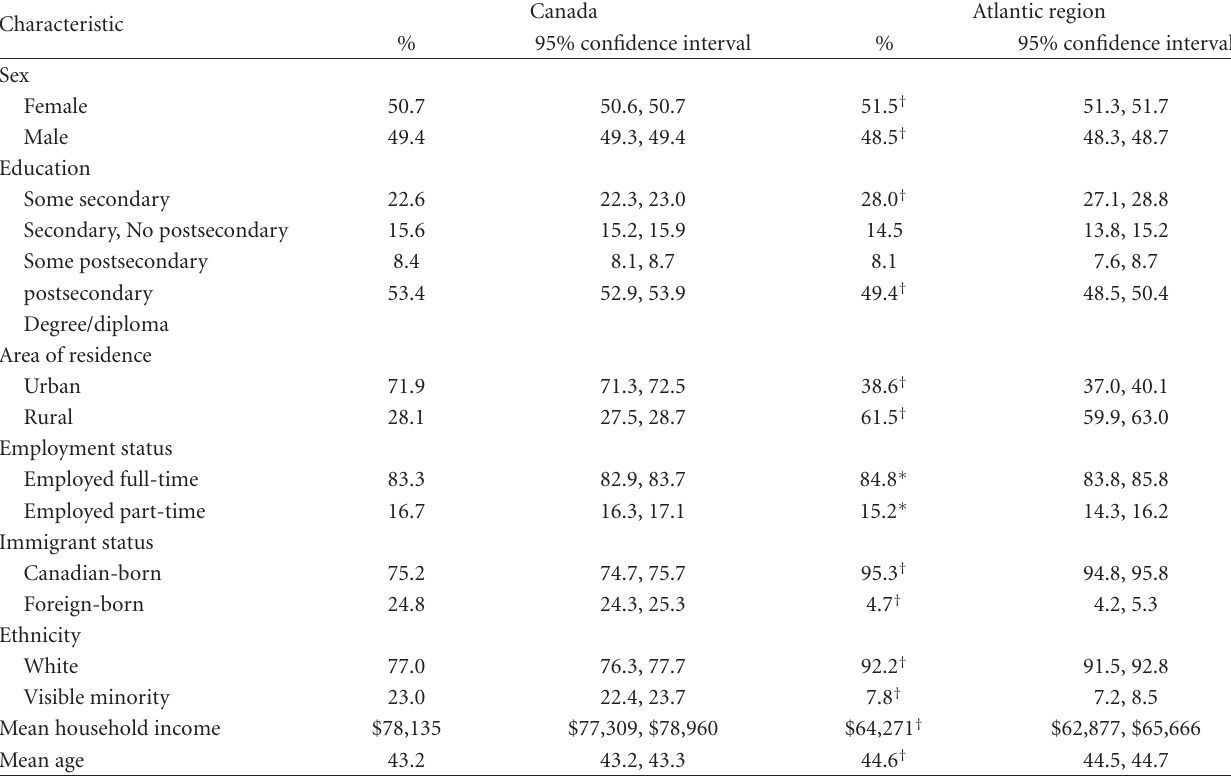
Table 1: Comparison of sociodemographic characteristics between Canada and the Atlantic region, 2007-2008. Characteristic